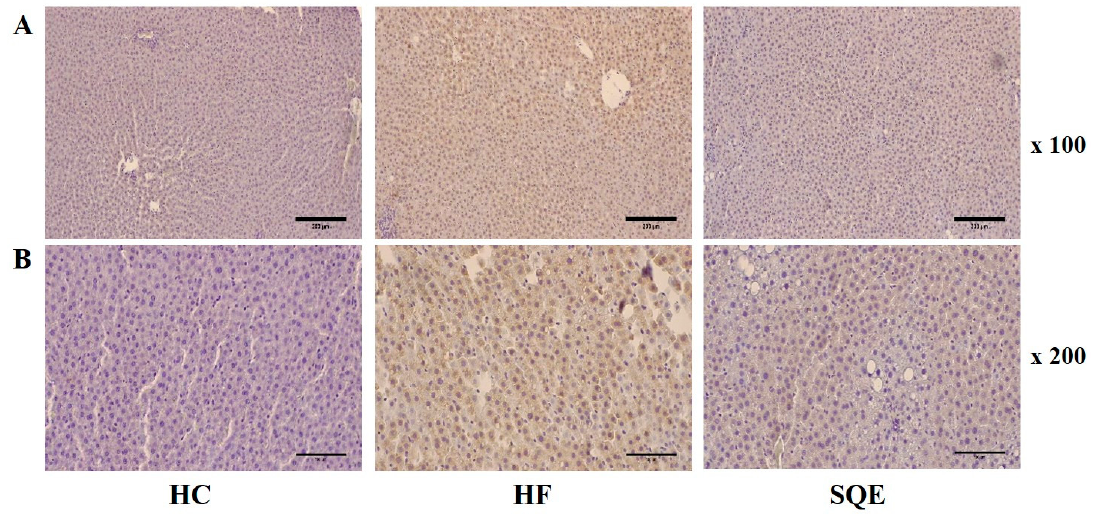
Figure 5. Effect of SQE supplementation on TNF α expression in liver tissues of HF-diet-fed rats. IHC staining against TNF α in liver paraffin sections at ×100 ( A ) and ×200 ( B ) magnification, with scale bars of 200 µm and 100 µm. HC, 46% carbohydrate diet; HF, 60% fructose diet; SQE, 60% fructose diet with SQE (500 mg/kg of BW) in drinking water. BW, body weight; HC, high-carbohydrate-diet-fed rats; HF, high-fructose-diet-fed rats; SQE, the high-fructose-diet-fed rats supplemented with S. quelpaertensis leaf extract.